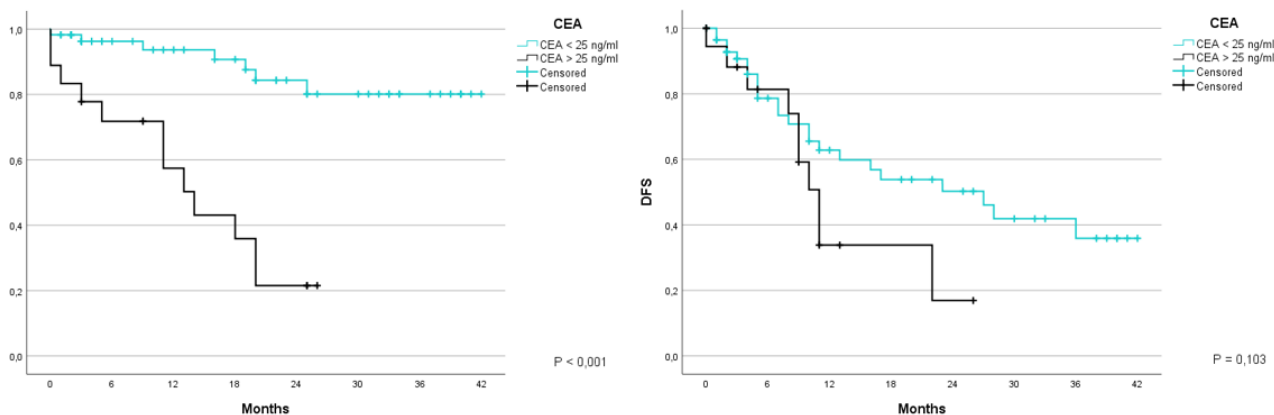
Figure 4. Kaplan-Meier Curve for OS and DFS in patients who underwent liver resection for CRLM stratified according to the primary tumor’s N stage. OS: Overall Survival; DFS: Disease Free Survival; CRLM: Colorectal liver metastasis.